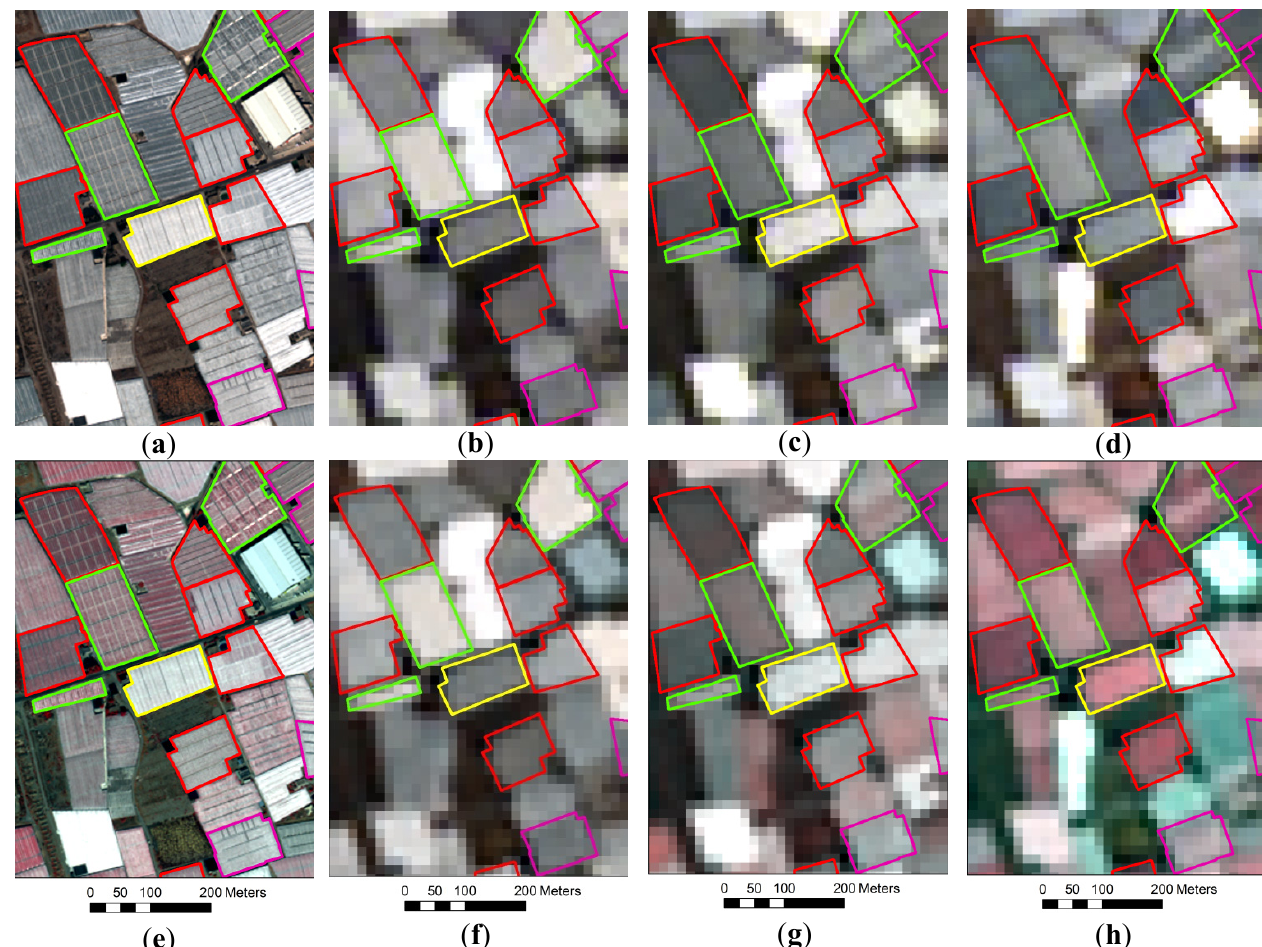
Figure 5. WV2 MS and multi-temporal Landsat 8 pan-sharpened orthoimages showing the evolution of some reference greenhouses. ( a ) WV2 true color composite (RGB) 30 September; ( b ) Landsat 8 RGB 11 August; ( c ) Landsat 8 RGB 12 September; ( d ) Landsat 8 RGB 15 November; ( e ) WV2 false color composite (NIR R G) 30 September; ( f ) Landsat 8 false color 11 August; ( g ) Landsat 8 false color 12 September; ( h ) Landsat 8 false color 15 November. Reference objects in red, green, purple and yellow represent tomato, pepper, aubergine and cucumber crops,